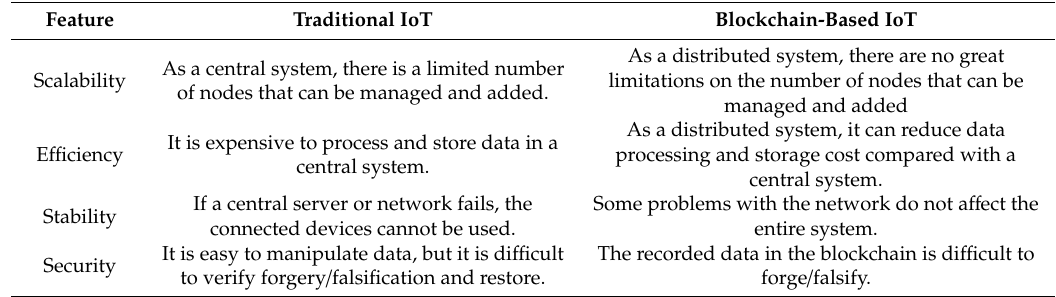
Table 1. Comparison between traditional the Internet of things (IoT) and blockchain-based